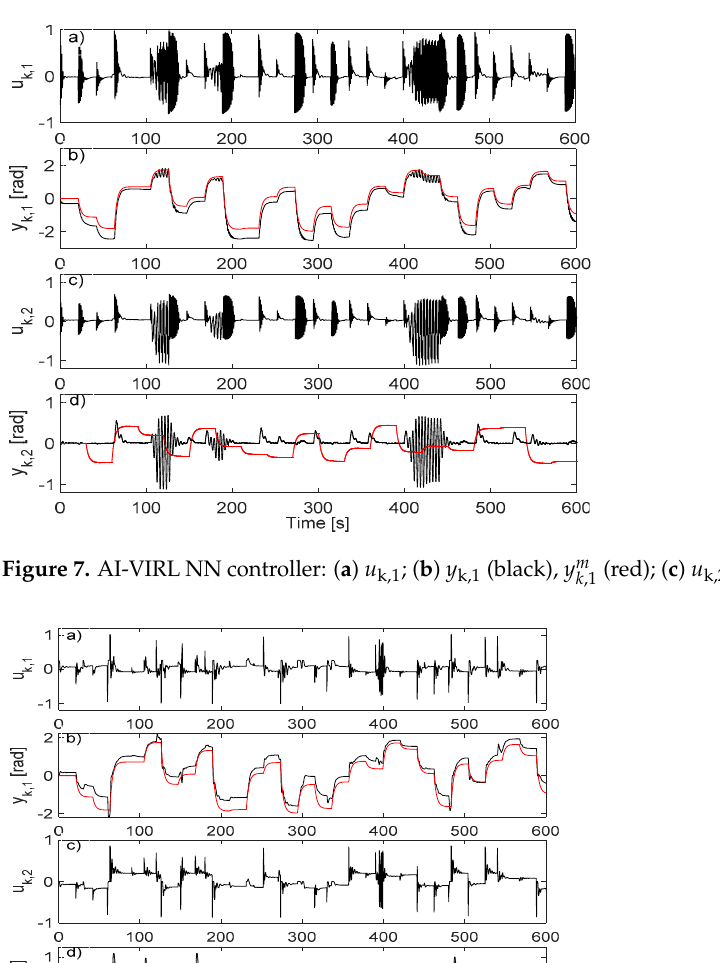
(red); ( c ) u k,2 ; ( d ) y k,2 (black), y m k ,1